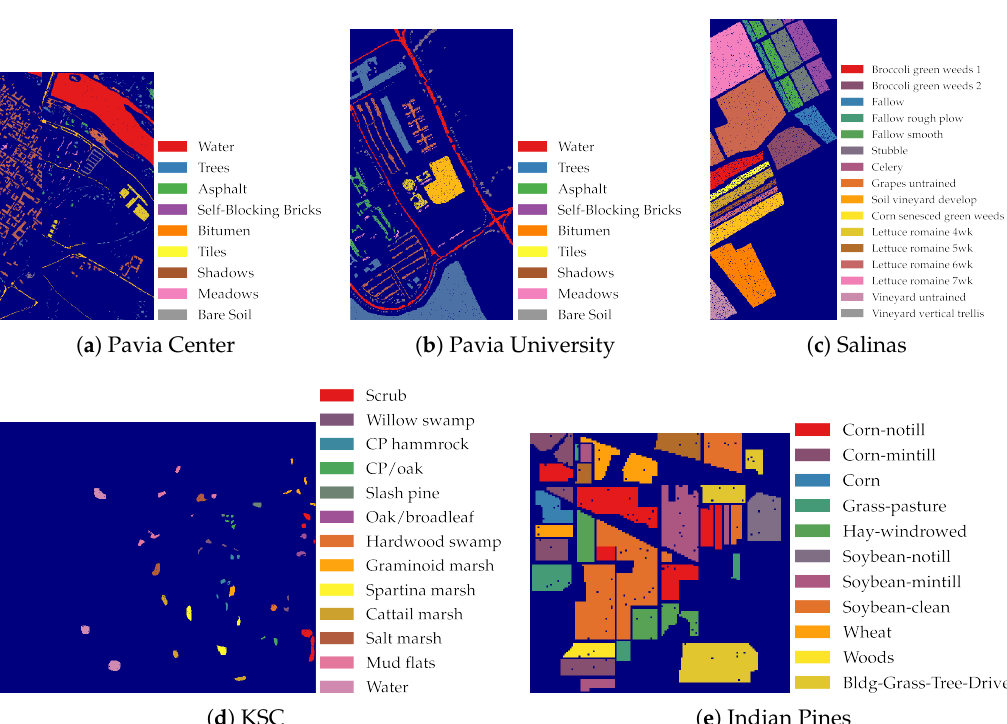
Figure 1. Unlabeled pixels for each of the considered hyperspectral